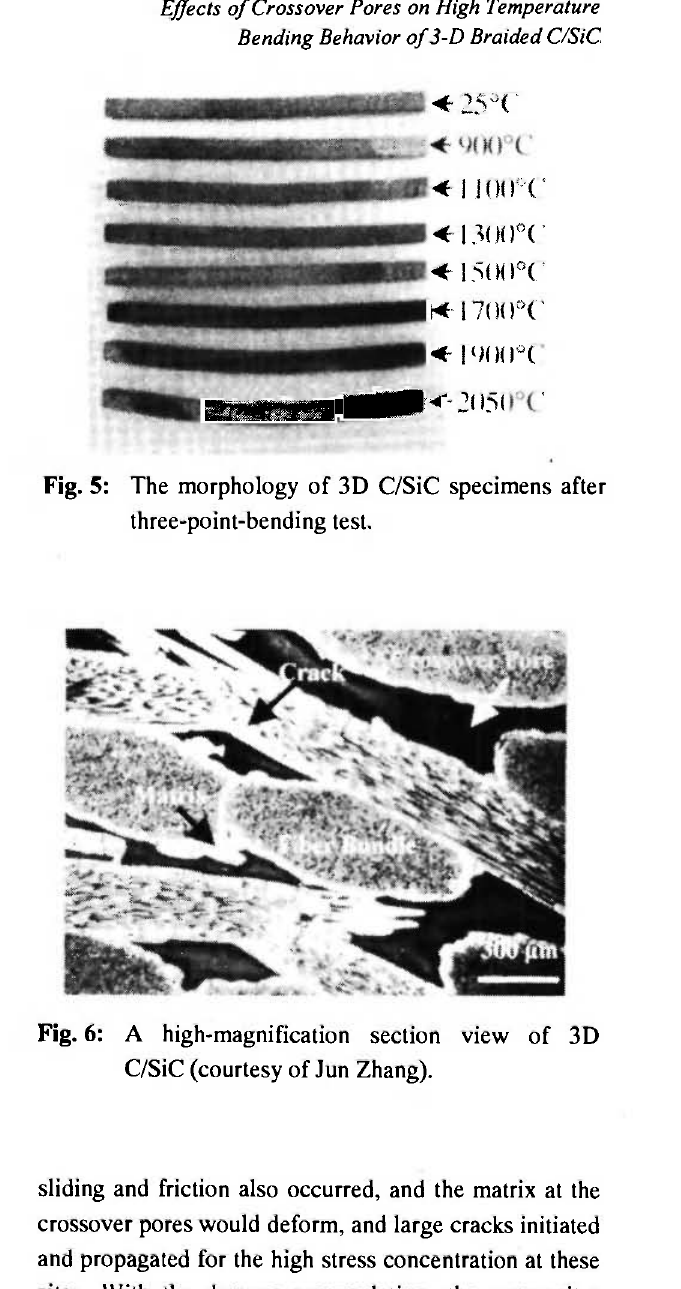
Fig. 6: A high-magnification section view of 3D C/SiC (courtesy of Jun